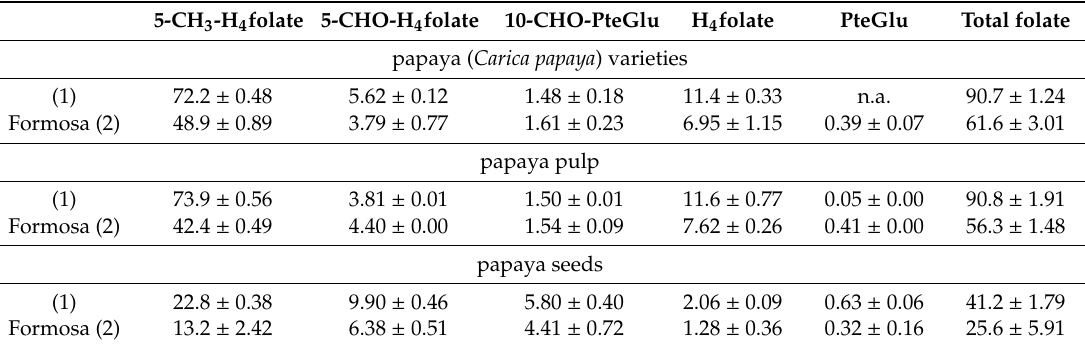
Table 3. Total folate content ( µ g / 100 g, calculated as PteGlu) in papayas.